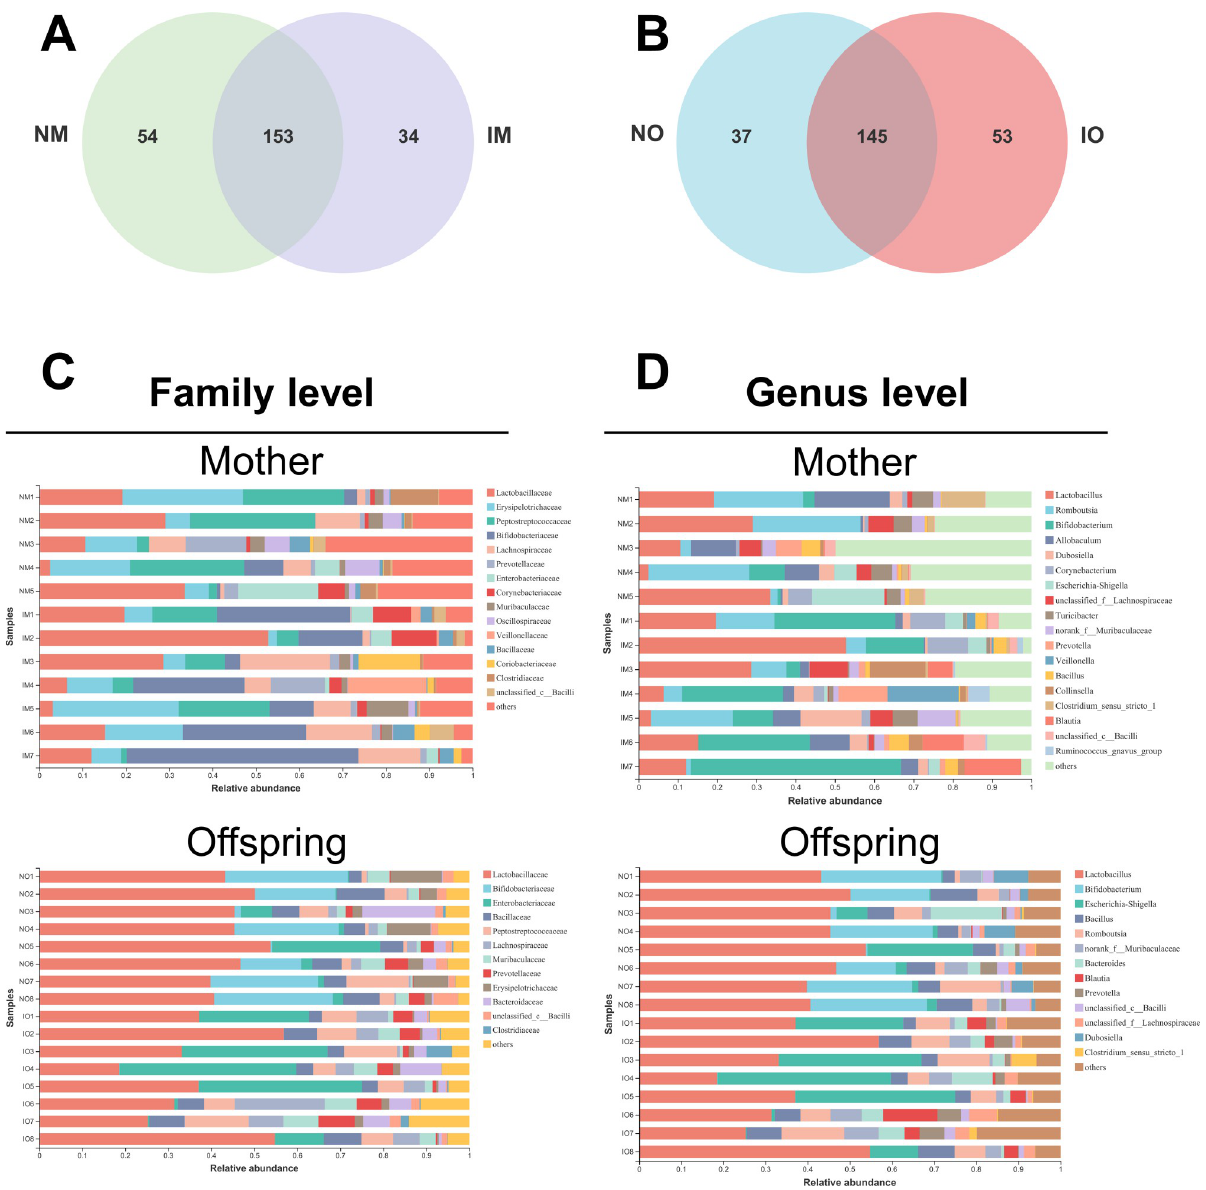
Fig 4. Fecal microbial composition analysis on maternal rats and offspring. (A, B) Shared ASV analysis of the maternal and offspring groups. Venn diagram revealed the unique and shared ASVs in the different groups; (C, D) Analysis on the fecal microbial composition of the maternal and offspring groups on the family level and genus